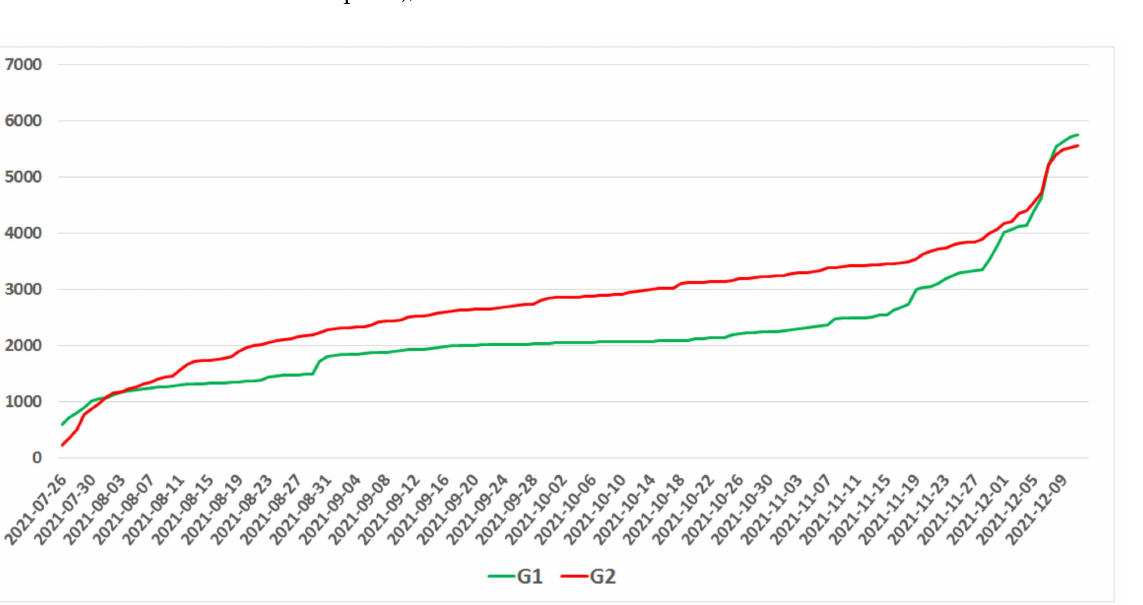
Figure 2. The size of the G1 (advocates) and G2 (opponents) groups throughout the analysed time period. The G1 group was larger than the G2 group only at two time points: at the very beginning of the period under study, when the recommendation of the governmental medical council to introduce a vaccination mandate aroused great interest, and at the end, when the decision to introduce a vaccination mandate was